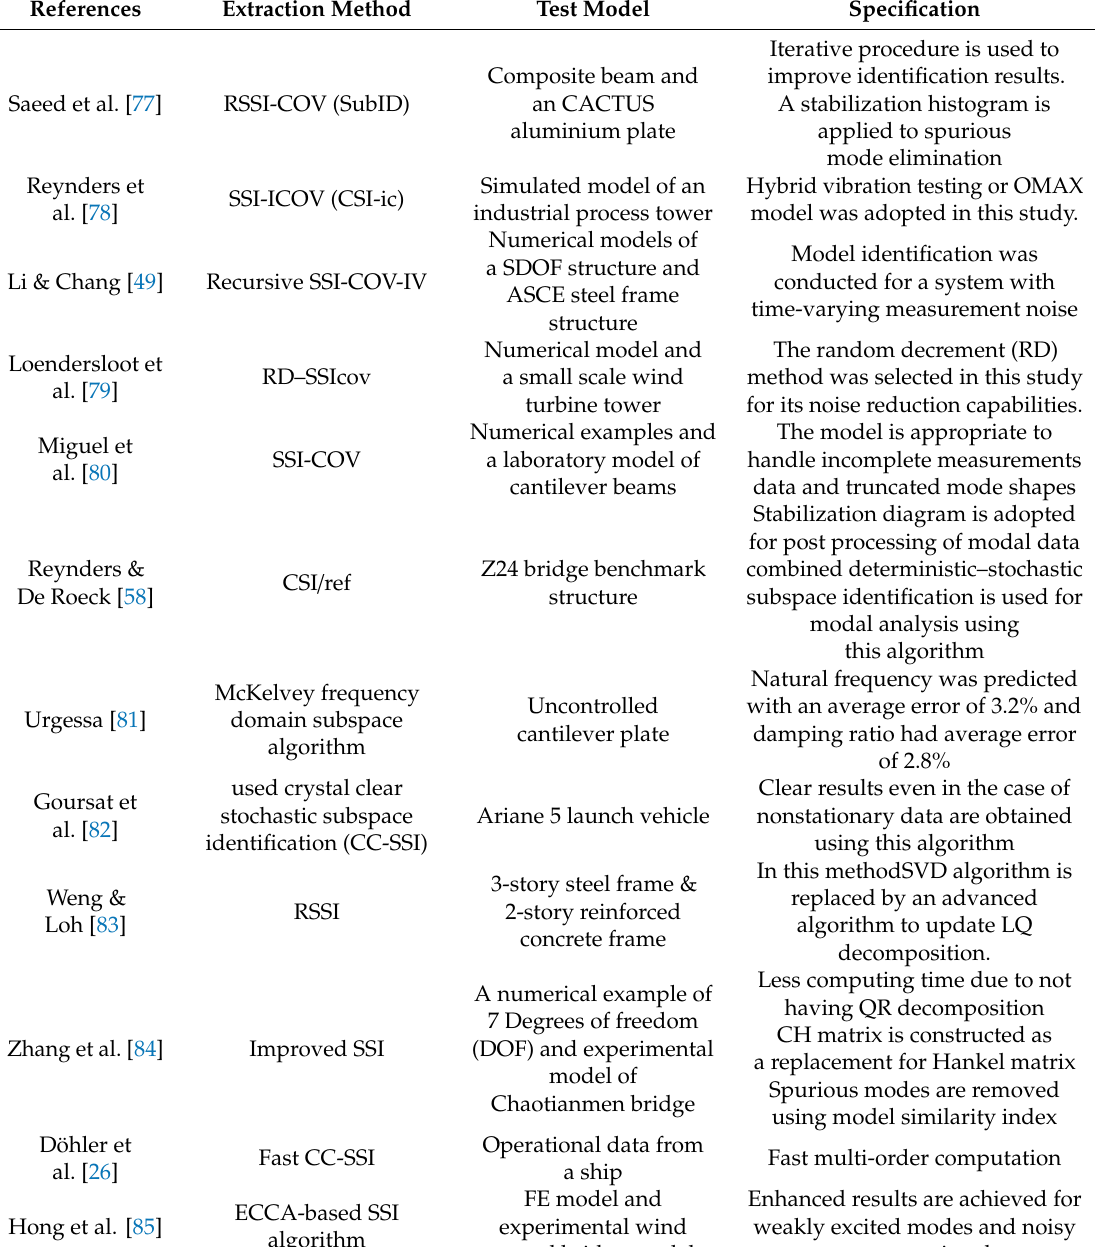
Table 1. Some examples of the schemes that use subspace algorithm for modal